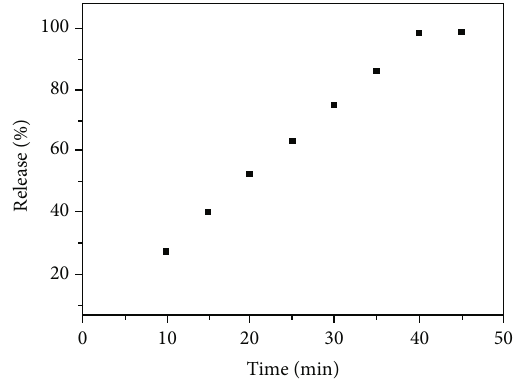
Figure 51: Release kinetics of β -carotene from polyamide microcapsules in tetrahydrofuran at 20 ° C